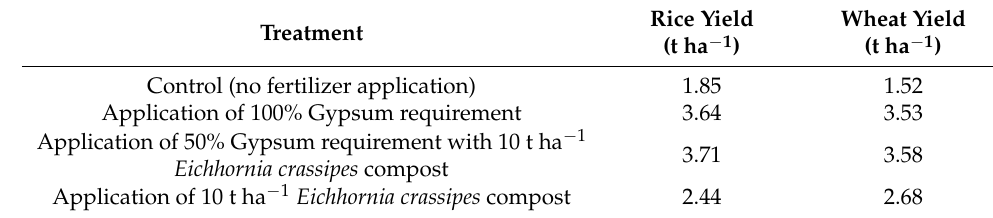
Table 5. Effect of Eichhornia crassipes compost and gypsum on rice and wheat yield